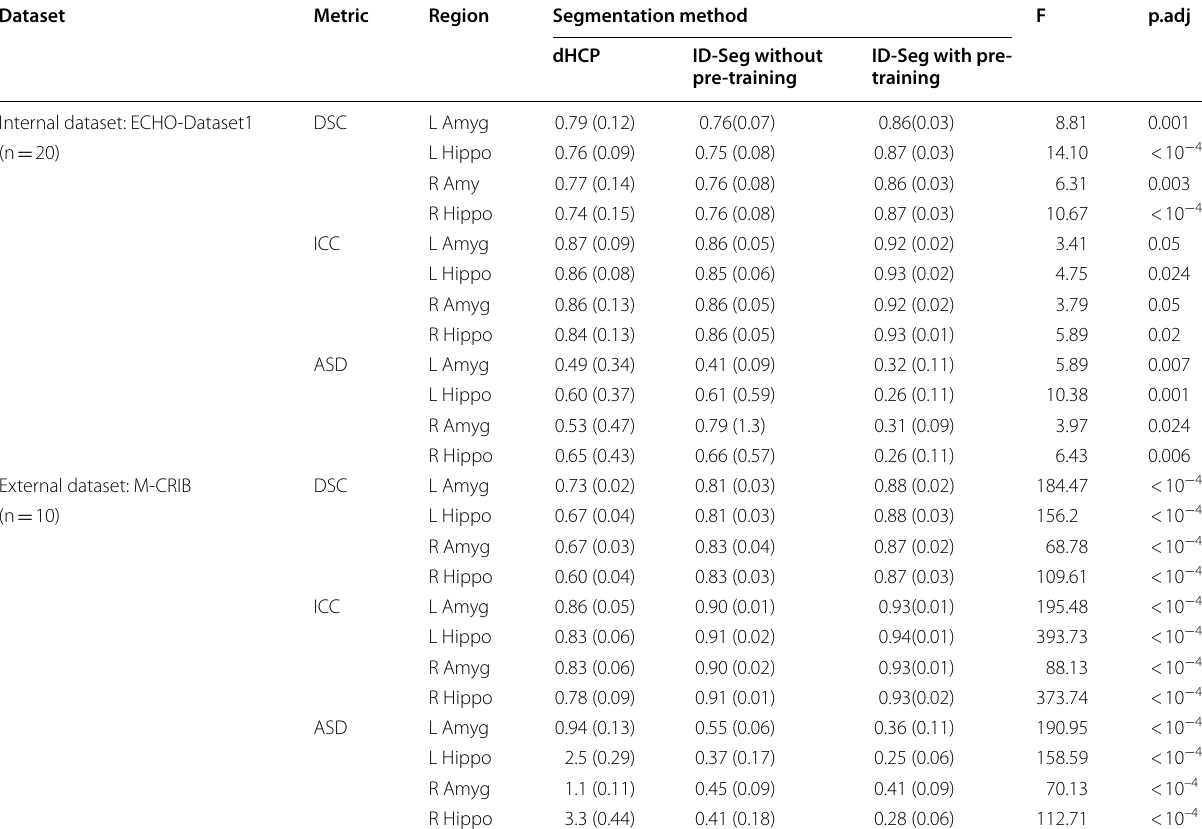
Table 2 Segmentation evaluations and